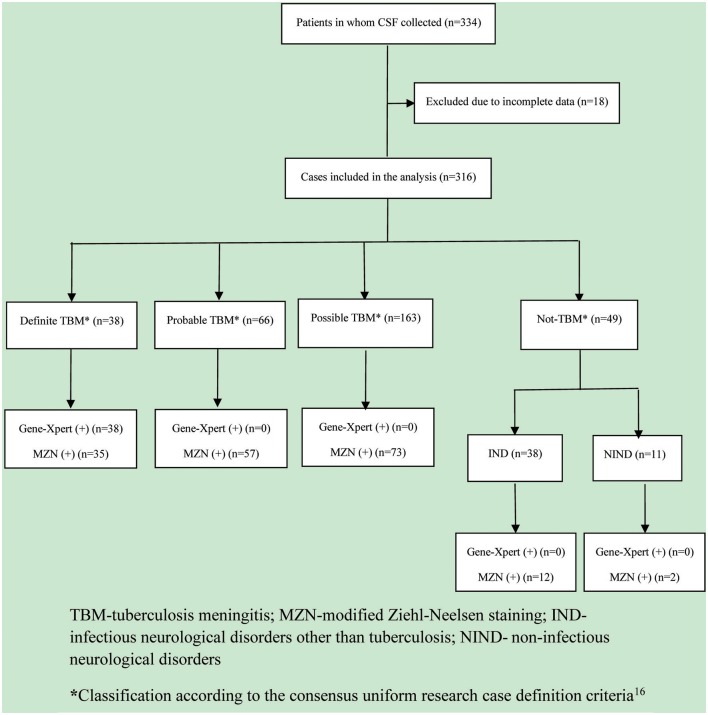
Flow diagram of patients evaluated for tuberculous meningitis. TBM, tuberculosis meningitis; MZN, modified Ziehl-Neelsen staining; IND, infectious neurological disorder other than tuberculosis; NIND, non-infectious neurological disorder. *Classification according to the consensus uniform research case definition criteria (Marais et al., 2010).